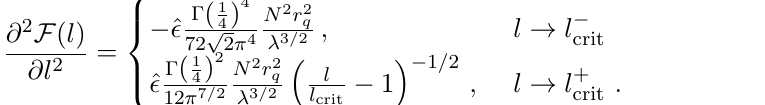
Figure 7 . F monotonically interpolates between constant values at the UV ( lr q = p IR ( lr q = (cid:21) ! 1 ) conformal (cid:12)xed points. The vertical dashed line is at l q r q = width of the strip whose bulk minimal surface just touches the cavity. The points are from the full numerical solution and the continuous curve is from our analytic results in the few (cid:13)avor limit (small ^ (cid:15) ). Here ^ (cid:15) = 0 :